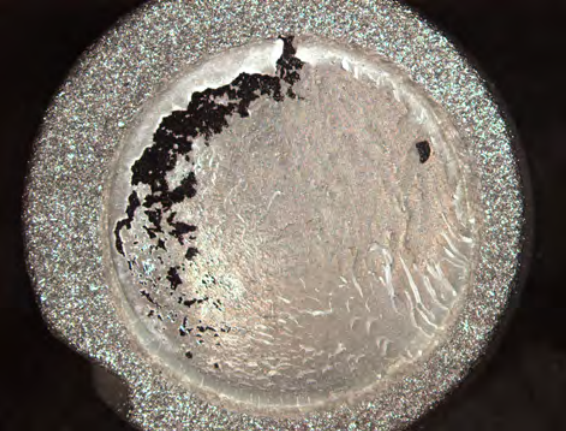
Figure 2. Titanium CP grade 2.